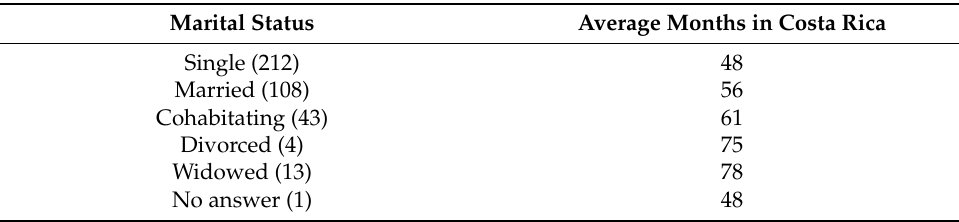
Table 3. Marital status and time in Costa Rica from the 1999 Costa Rica Survey.